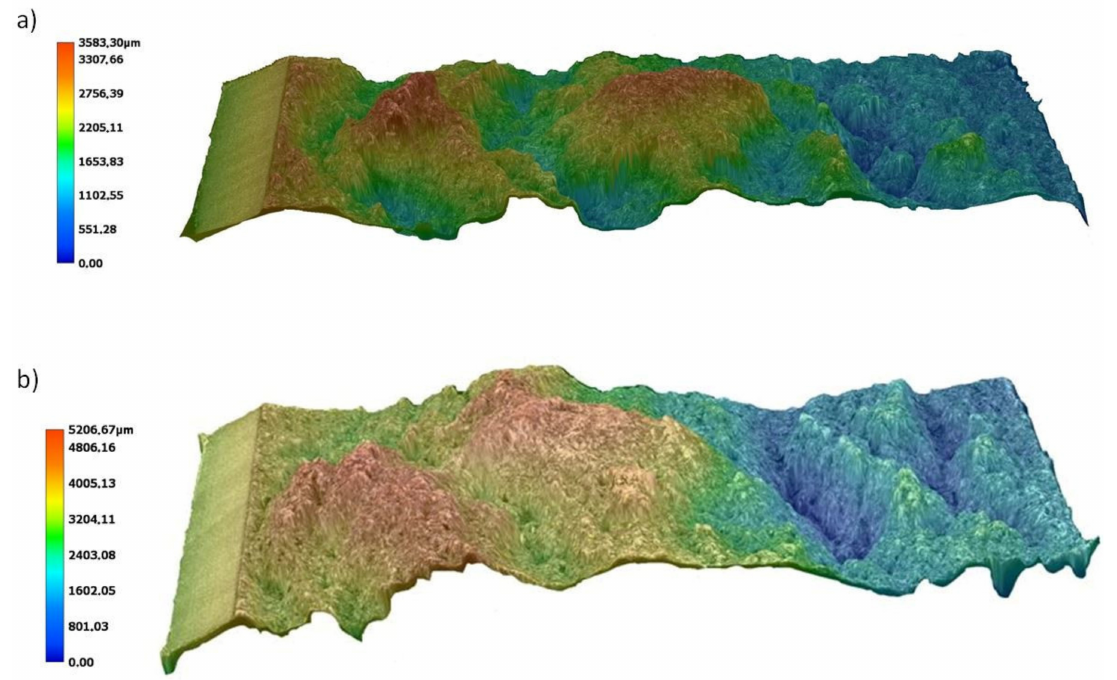
Figure 20. Topography of fractures of samples with a thickness of 8.4 mm obtained in impact tests: ( a ) unfoamed sample A8, ( b ) sample C8 foamed with 20 MPa nitrogen